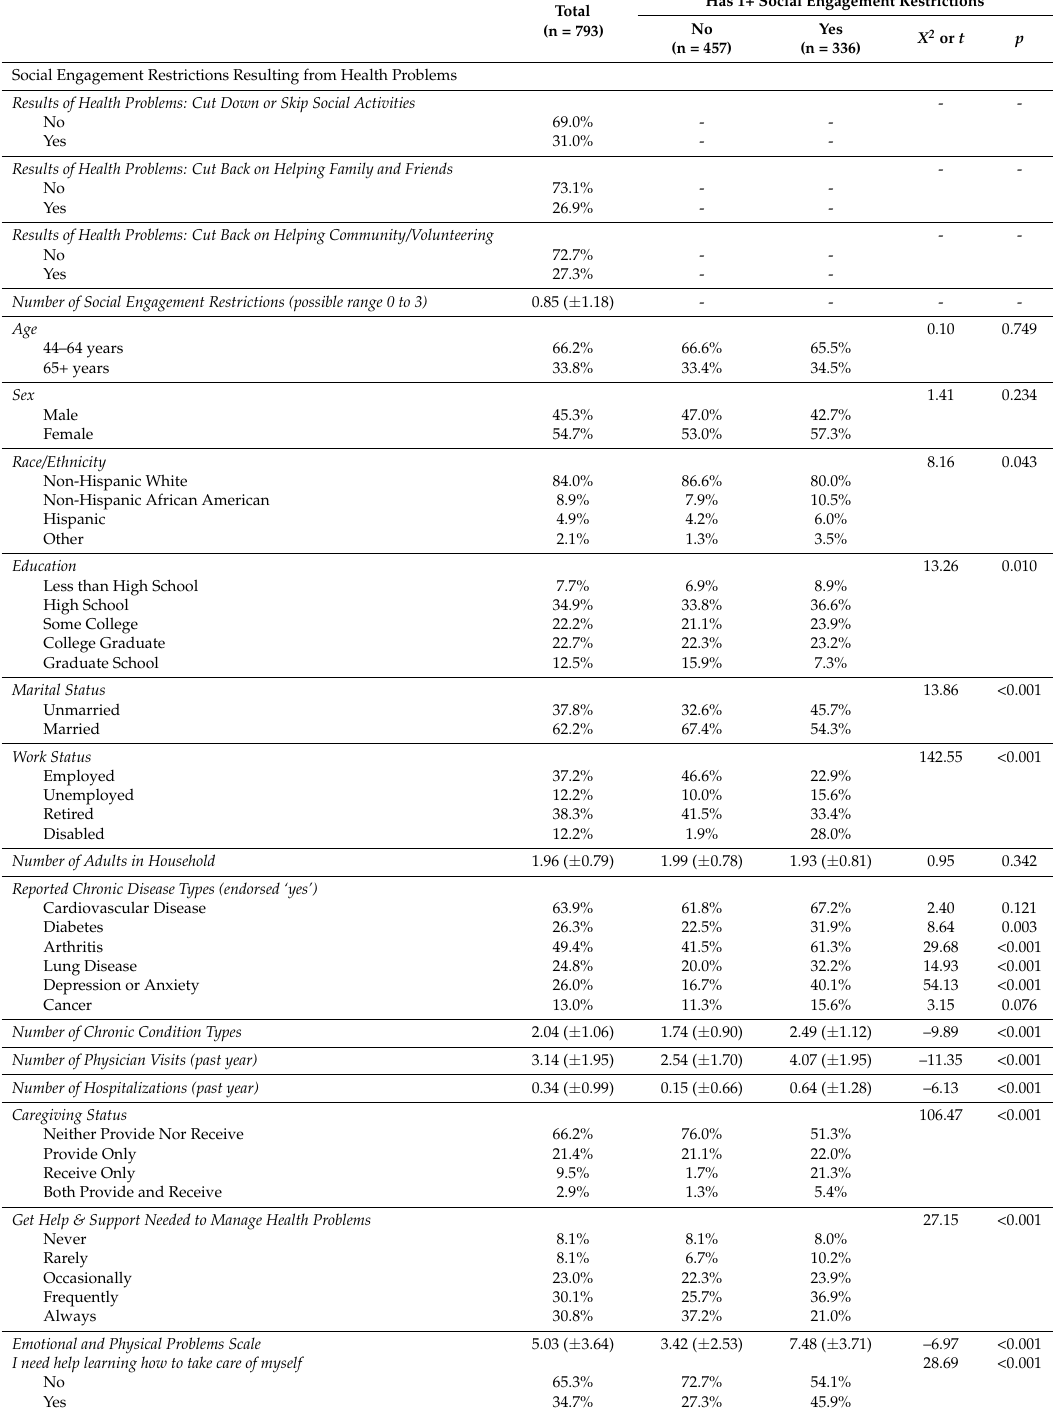
Table 1. Personal characteristics by social engagement self-restrictions resulting from health